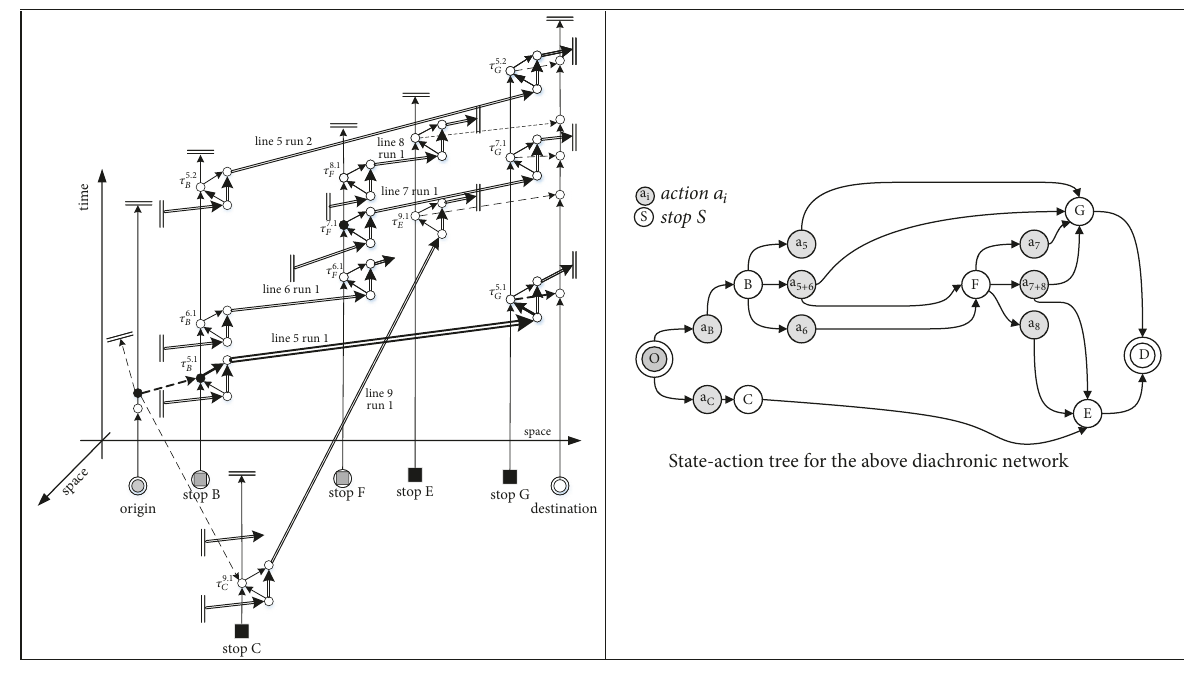
Figure 2: Example of run hyperpath with a diversion choice at